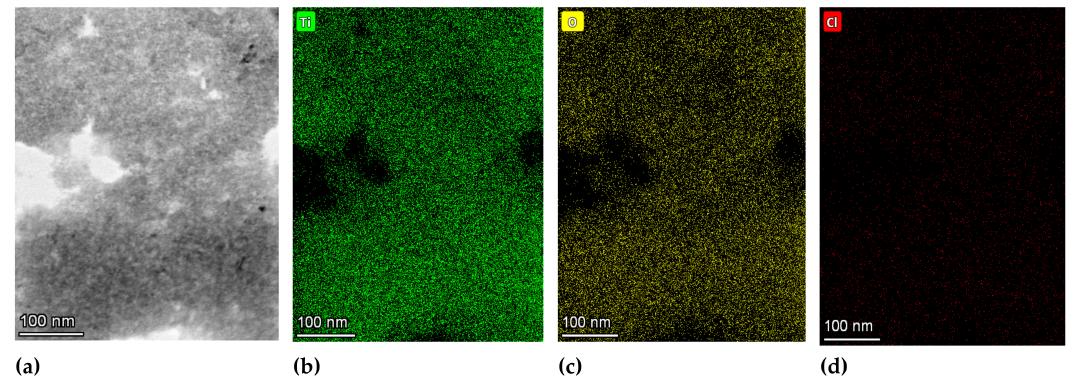
Figure 6. TEM bright-field image ( a ) and elemental distribution maps for Ti ( b ), O ( c ), and Cl ( d ) on an area of sample TiO 2 _60_Powd. Denser fractions of the sample appear as more intense